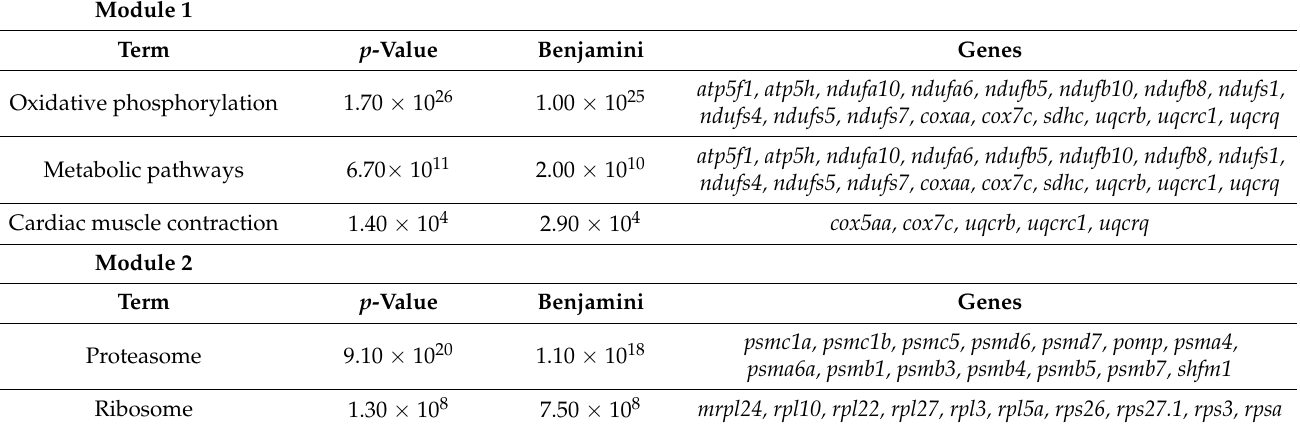
Table 5. KEGG pathways of DEGs from Module 1 and Module 2 from the PPI network in the liver of zebrafish affected by